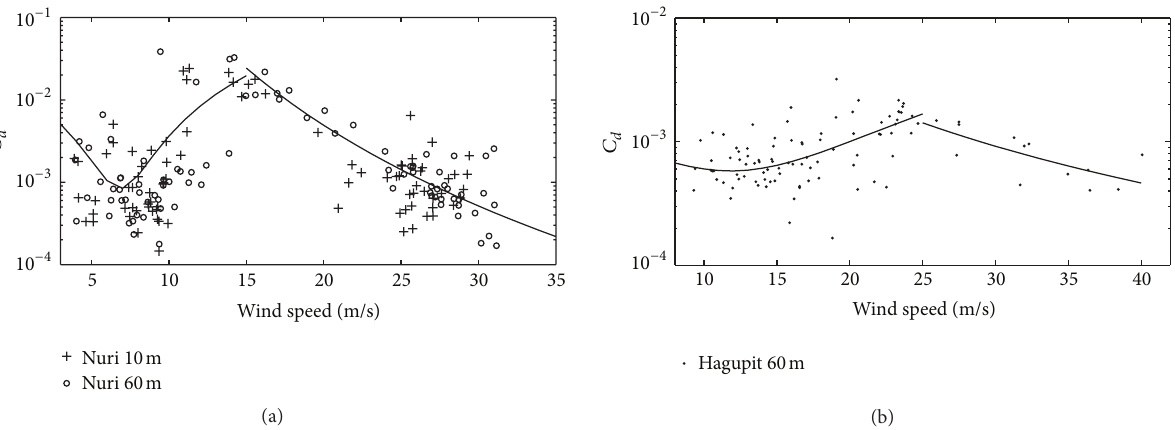
Figure 8: Drag coefficient as a function of wind speed during strong typhoons in onshore direction: (a) typhoon Nuri and (b) typhoon